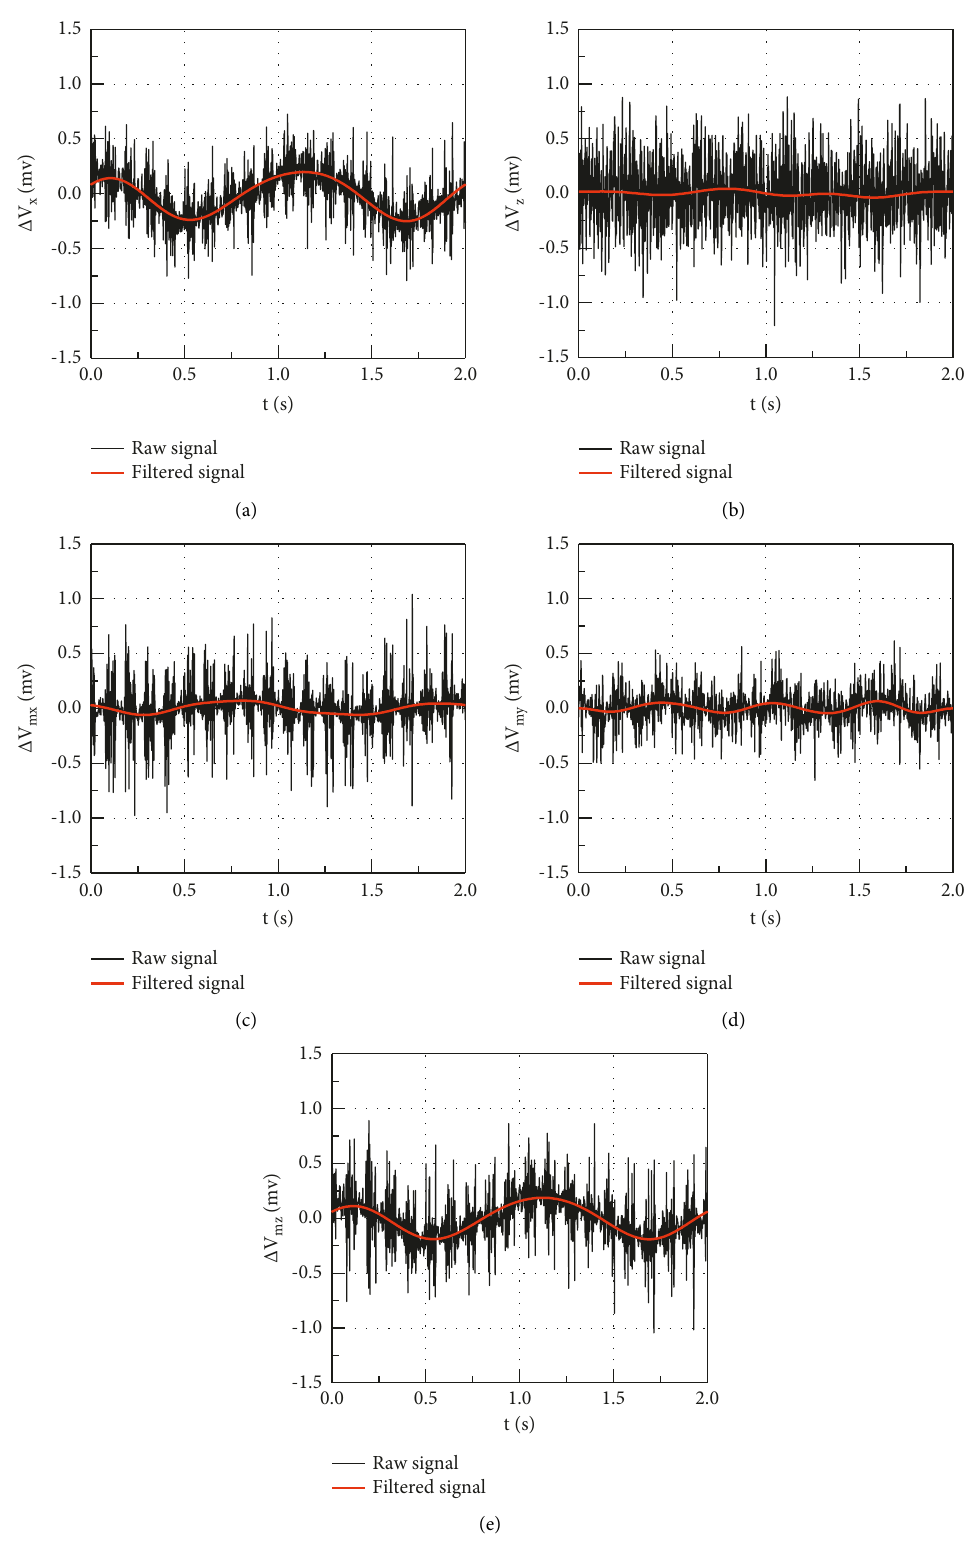
Figure 3: Raw and filtered signal output by the strain balance with respect to the acquisition time. The zero-point reference set has been subtracted (a) Δ V x – t , (b) Δ V z – t , (c) Δ V mx – t , (d) Δ V my – t , and (e) Δ V mz – t ( K � 0.12, α � 0 ° , and t �